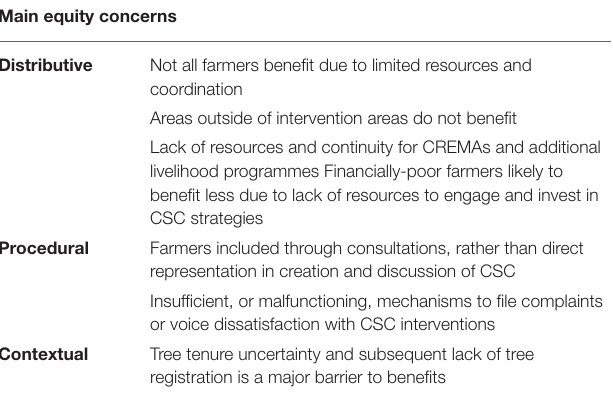
TABLE 4 | Summary of CSC’s main equity concerns encountered during field